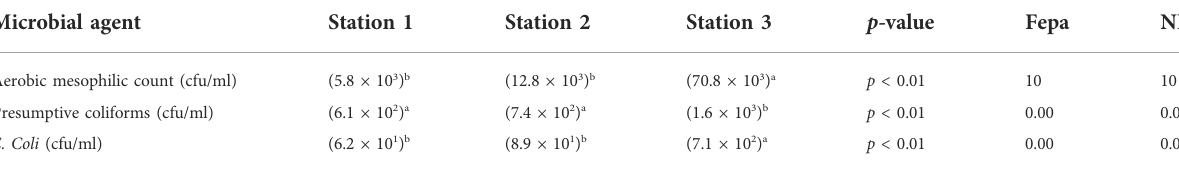
TABLE 2 Results of the selected microbial properties of the sampled stations at the Orogodo River.